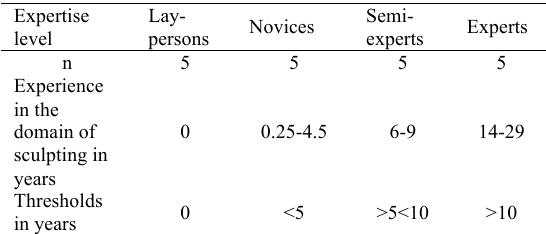
Table 1. Classification of experience in the domain of sculpting in years into expertise levels by